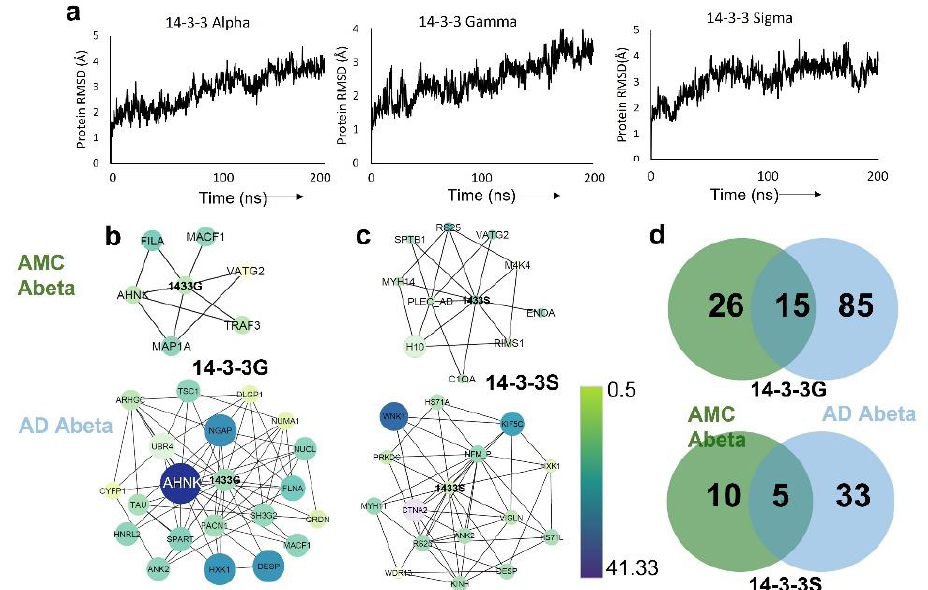
Figure 1 . Molecular dynamic simulations and interactome analyses of 14-3-3 paralogs. ( a ) RMSD trajectories of 14-3-3 paralogs in 200-ns simulations. ( b , c ) Amyloid beta interactome sub-networks of 14-3-3G ( b ) and 14-3-3S ( c ) in aggregates from AMC and AD, respectively; node color indicates relative protein abundances (see key). ( d ) Venn diagram showing the 14-3-3G-interacting protein counts unique to AMC or AD, or shared in common.